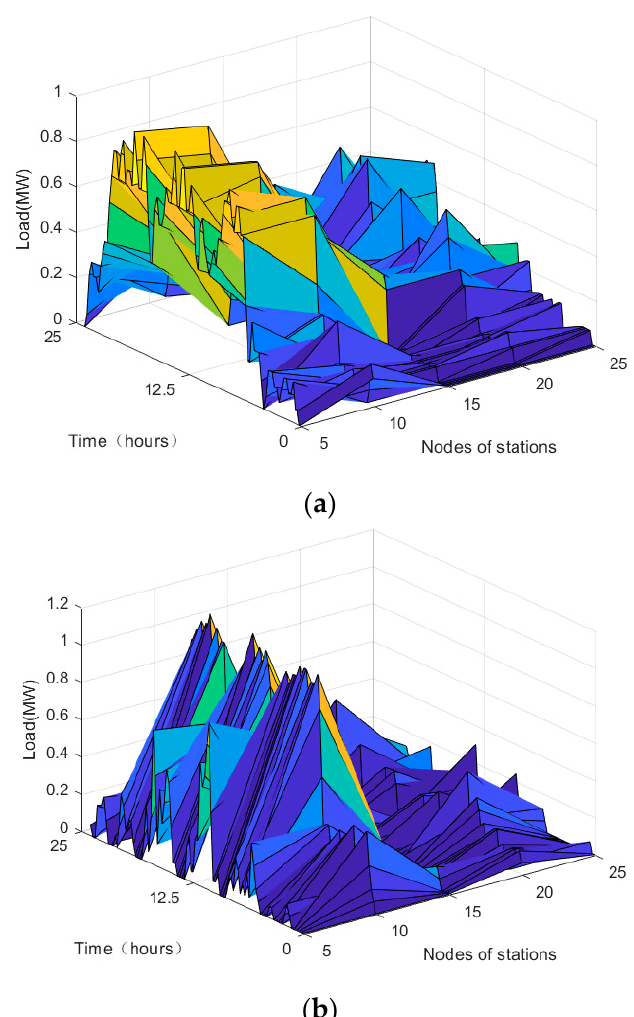
Figure 13. ( a ) Disorderly load without optimization; ( b ) Orderly load with optimization.